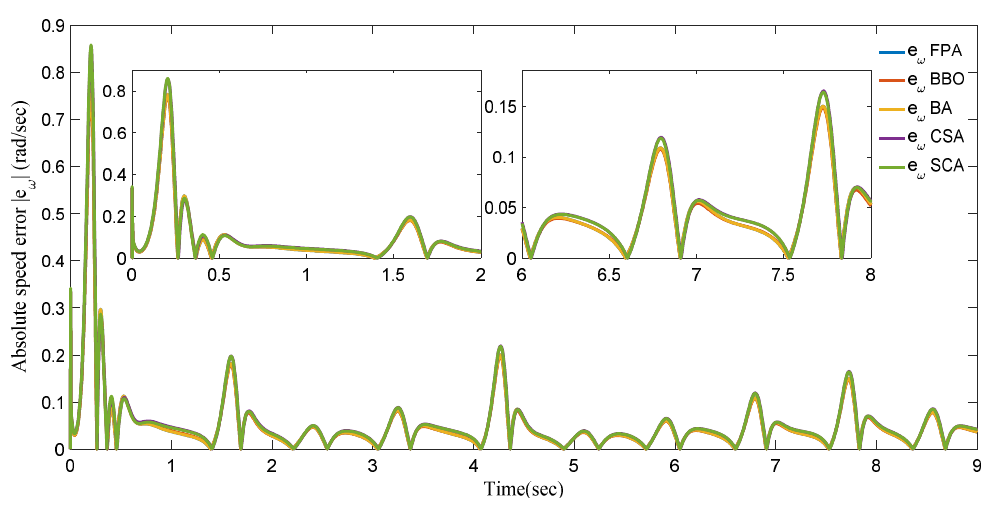
Figure 9. Waveforms of the rotor speed error performance, Case 1.